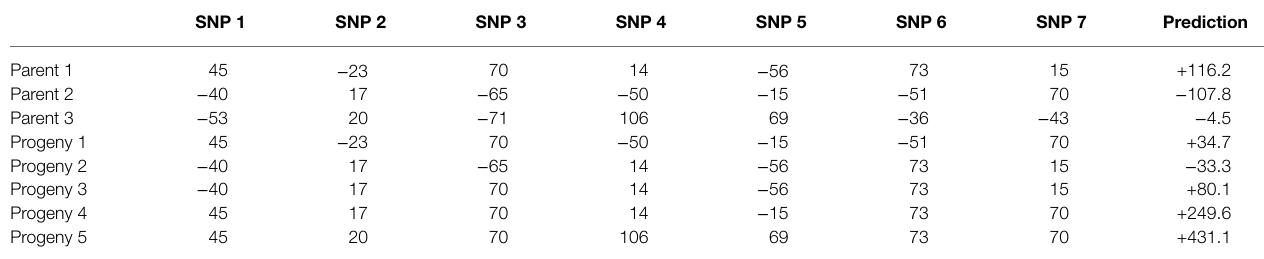
TABLE 1 | Simplified matrix showcasing parents, five potential progenies, and their